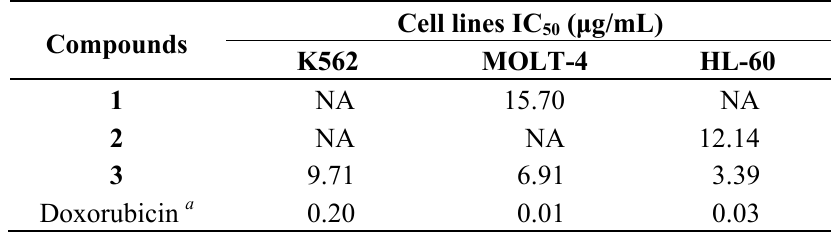
Table 2. Cytotoxic data of sterols 1 – 3